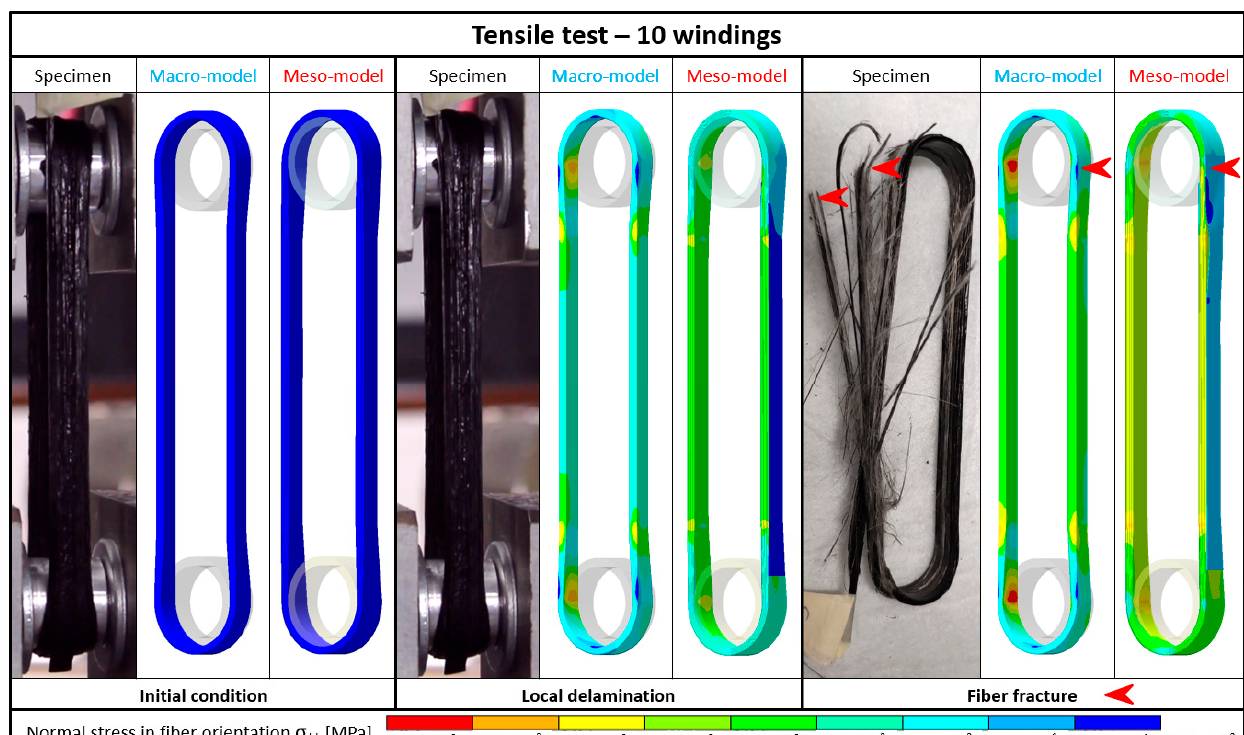
Figure 20. Deformation and failure behavior of simple loops with ten windings (specimens and models).